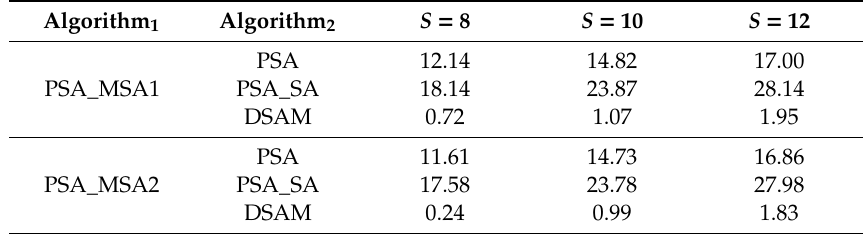
(cid:48) Table 4. Comparison results ( ∆ Kappa %) of di ff erent SPM models for the synthetic data Table 4. Comparison results ( Kappa' %) of different SPM models for the synthetic data set.